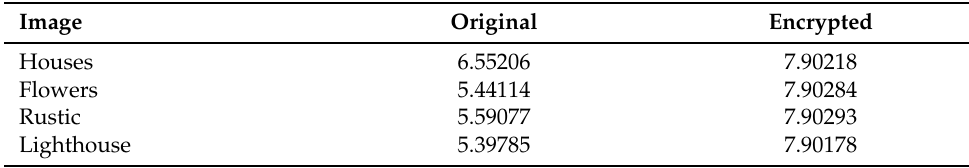
Table 14. Local information entropy for the examined dataset.